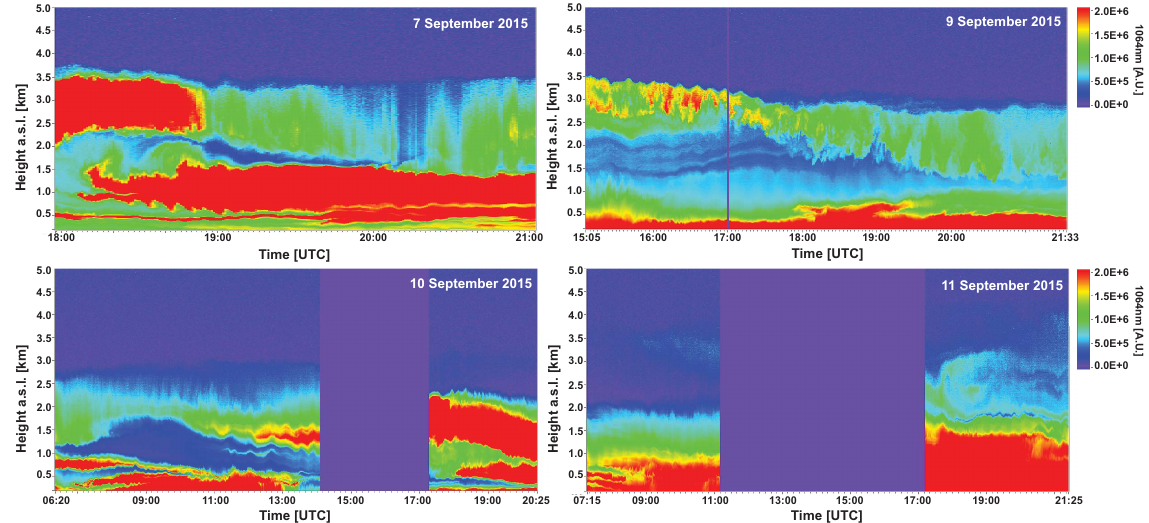
Figure 4. Desert dust layers observed with lidar over the EARLINET station of Limassol, Cyprus, on 7, 9, 10, and 11 September 2015. Range-corrected 1064nm backscatter signals (in arbitrary units, A.U.) are shown. On 7–10 September, a double layer structure dominated with dust layers below about 1–1.7km height and another layer reaching to 2.5–3.7km height. Local time (EEST) is time in UTC plus 3h.